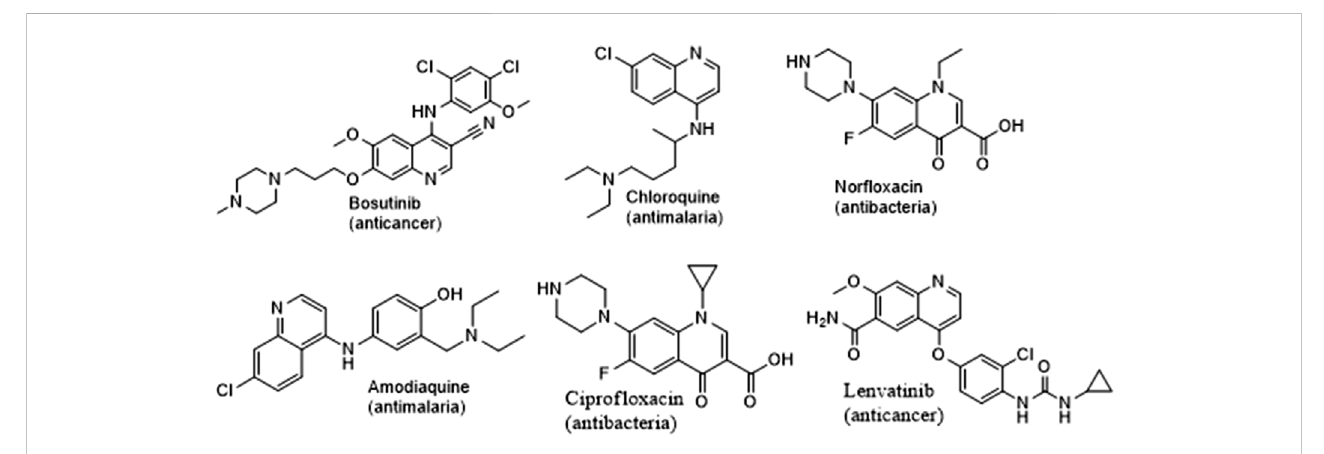
FIGURE 2 Structures of some commercially available quinoline containing